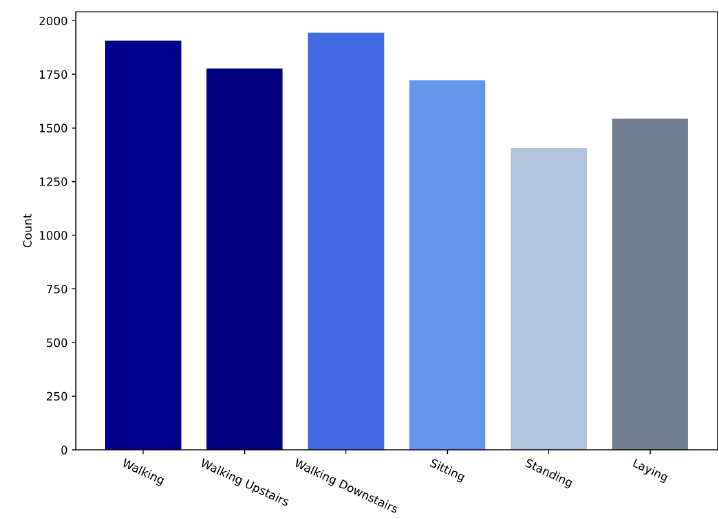
Figure 8. Activity label distribution of UCI-HAR